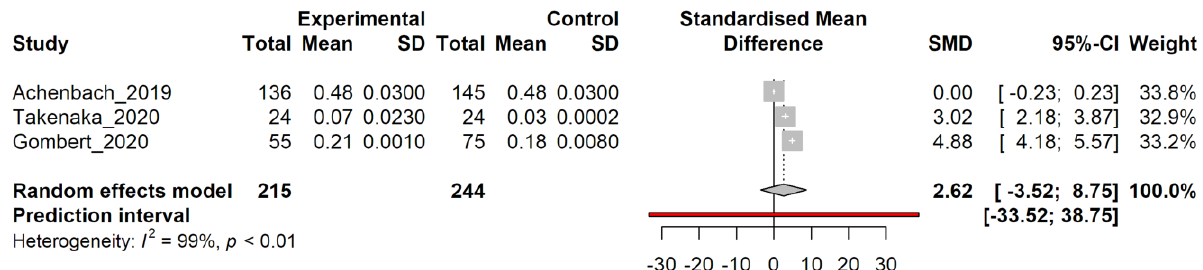
Figure 3. Random effect model analysis of group 1 papers. Study: the first author followed by the year of the study examined. Experimental/Control: data for affected/control groups. Total: number of subjects in each group. Mean: mean value of methylation level for each group. SD: standard deviation. Standardized mean difference: a graph showing the standardized mean differences for each study, with confidence intervals (grey squares). SMD: standardized mean difference value. A 95%-CI: confidence interval for 95% on SMD. Weight: statistical “weight” for each study. In bold characters, results from random effect model analysis are indicated as a graphical diamond on the standardized mean difference graph. Heterogeneity: results from heterogeneity test, I 2 , describes the percentage of variation across studies that is due to heterogeneity rather than chance, p : p -value derived from Cochran’s Q test.